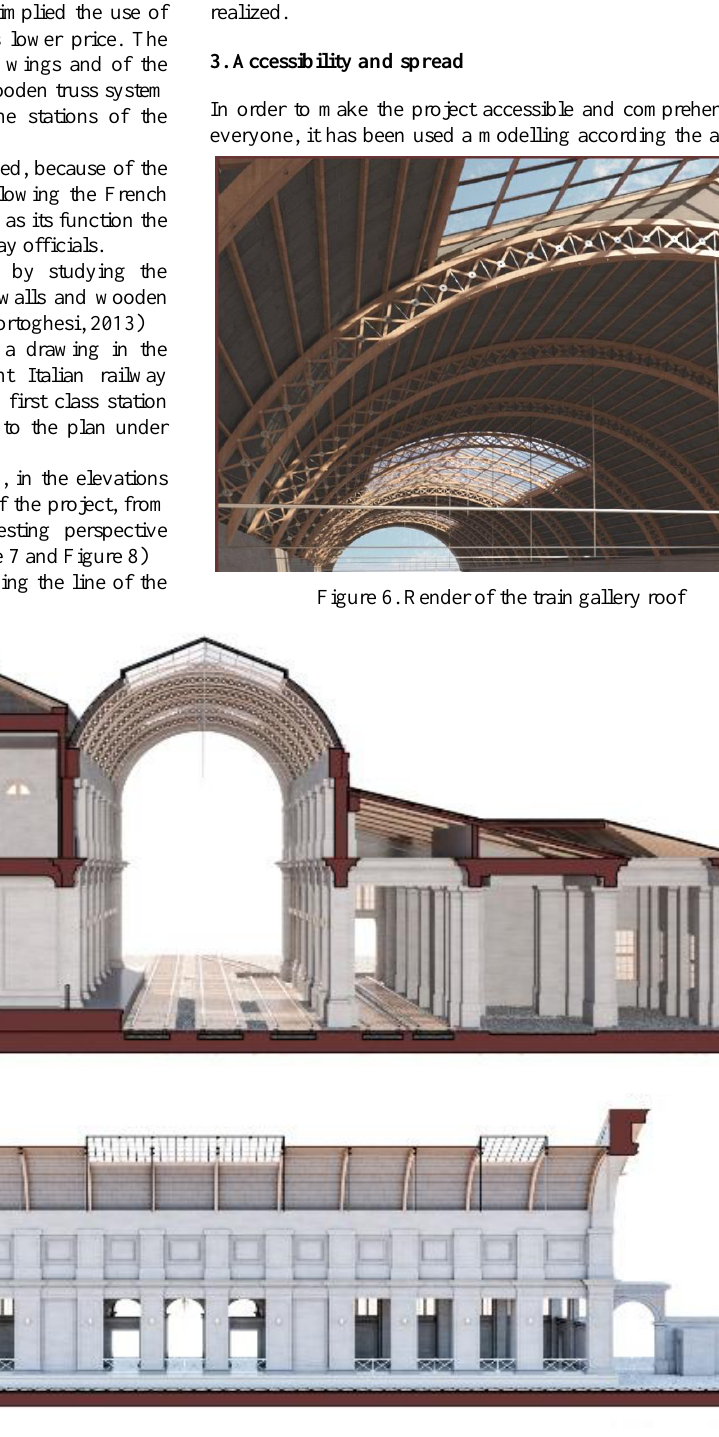
Figure 7. Perspective sections extracted and processed from the digital 3D